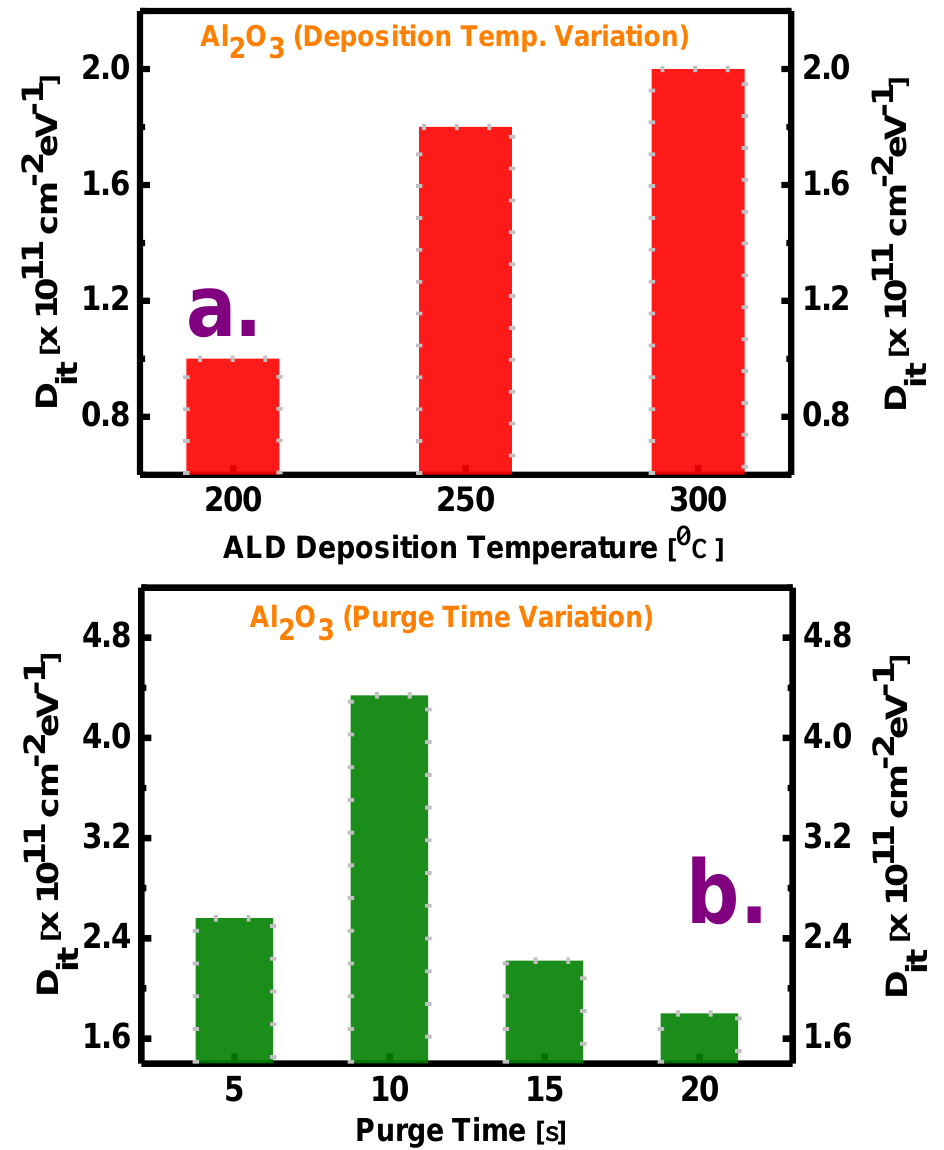
Figure 4. Comparison of the values of interface trap density ( D it ) measured for films ( a ) deposited at three temperatures (200, 250, and 300 °C) with a purge time of 20 s and ( b ) deposited with four purge times (5, 10, 15, and 20 s) at a deposition temperature of 250 °C.